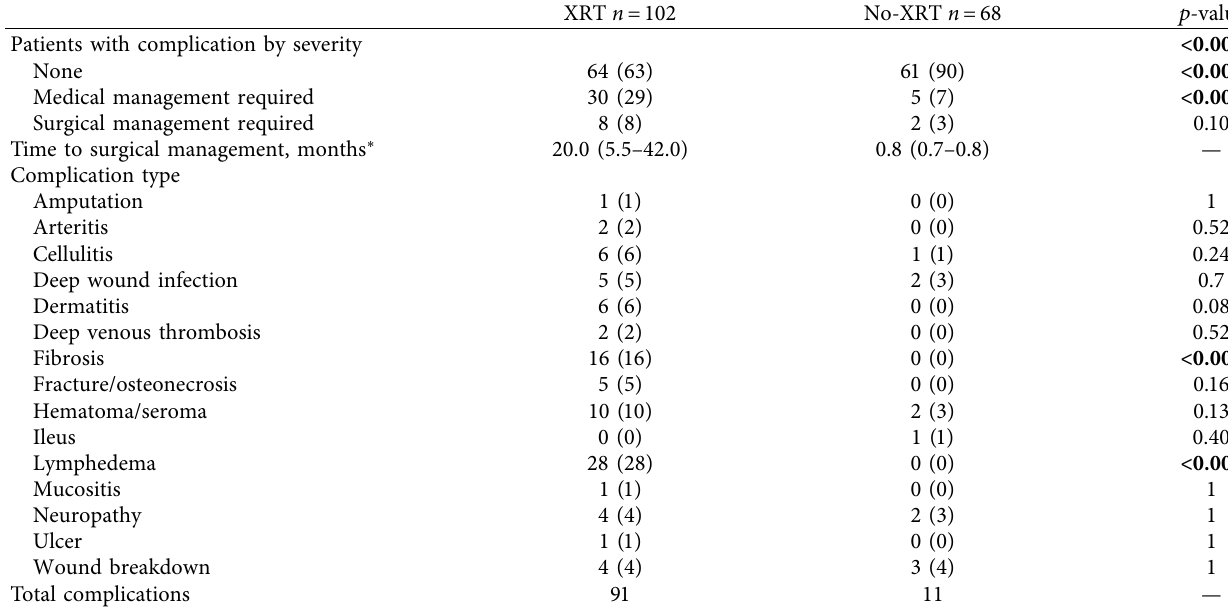
Table 4: Complication